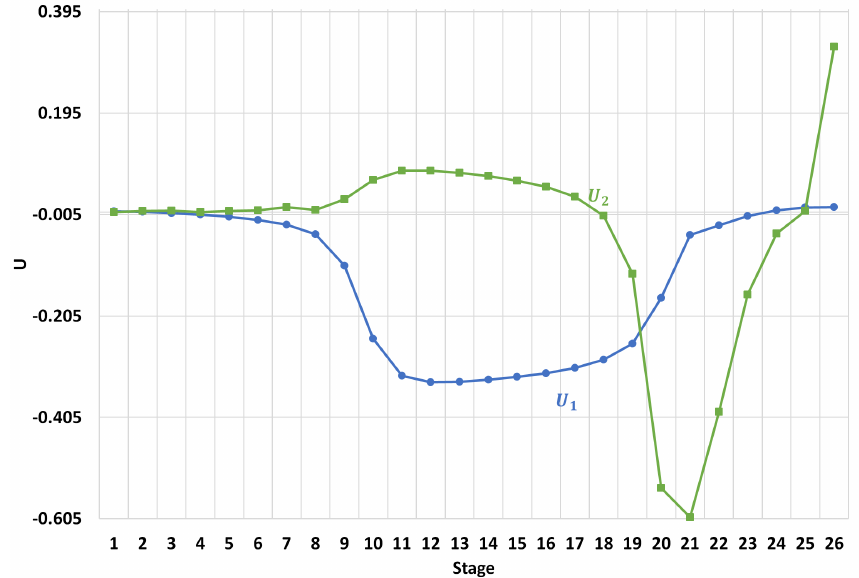
Figure 8. Singular value decomposition (SVD). Analysis of singular vectors U 1 and U 2 vs. stage location.